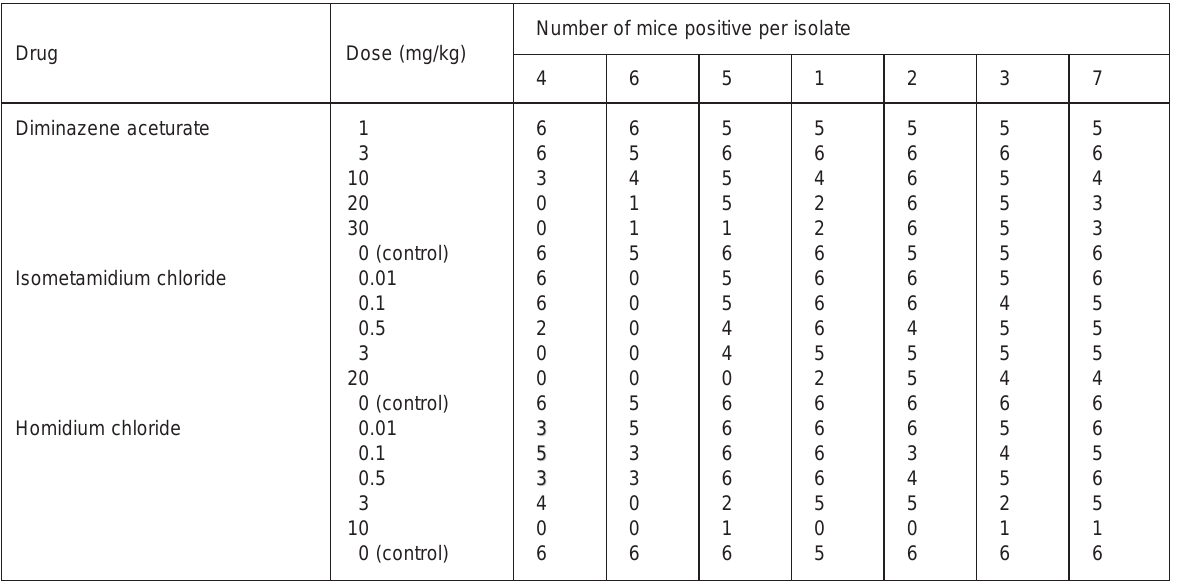
TABLE 1 Number of mice (out of a total of six) that relapsed after treatment with a trypanocide at various doses for each of the seven isolates